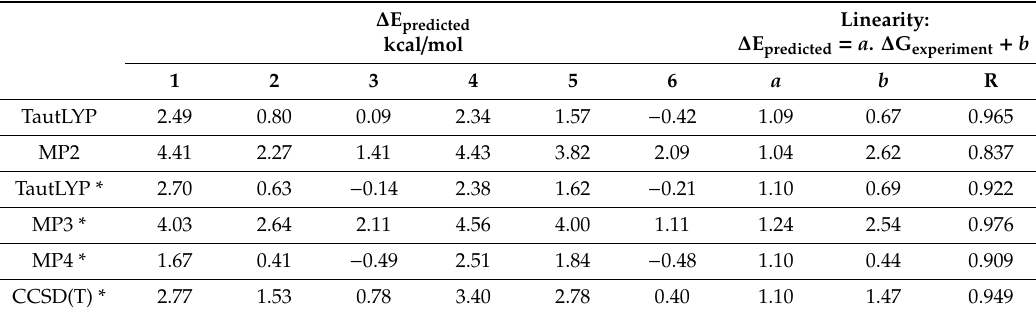
Table 6. Comparison between TautLYP and CCSD(T) in gas